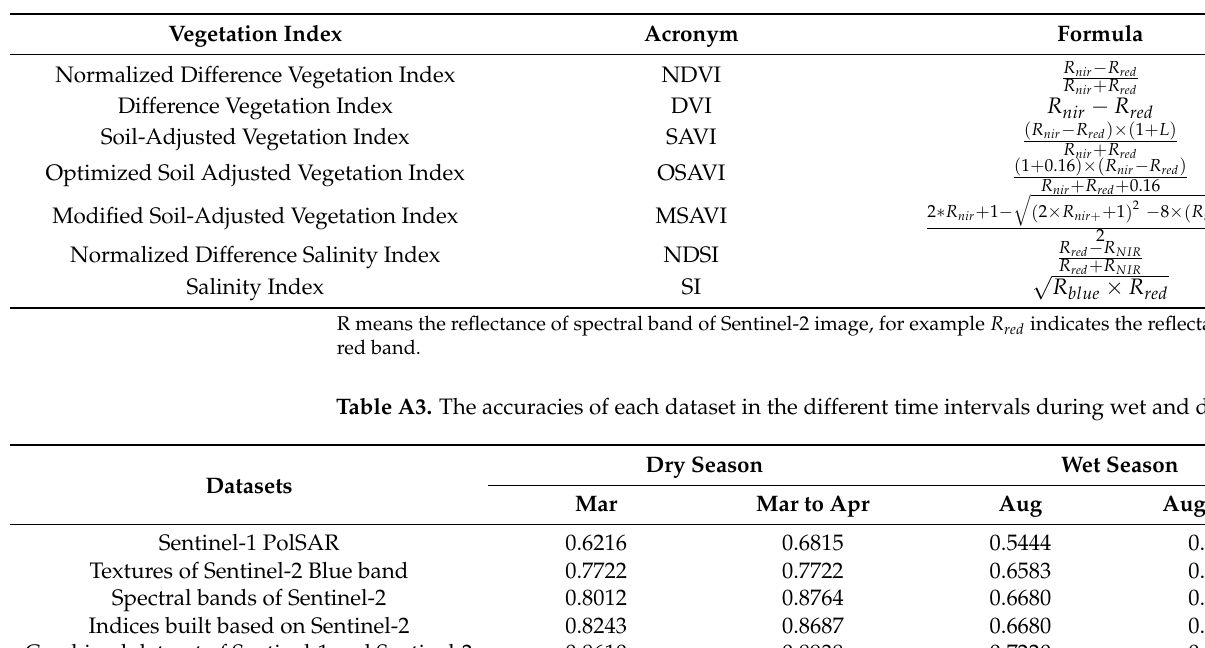
Table A2. Information list of reference spectral indices.